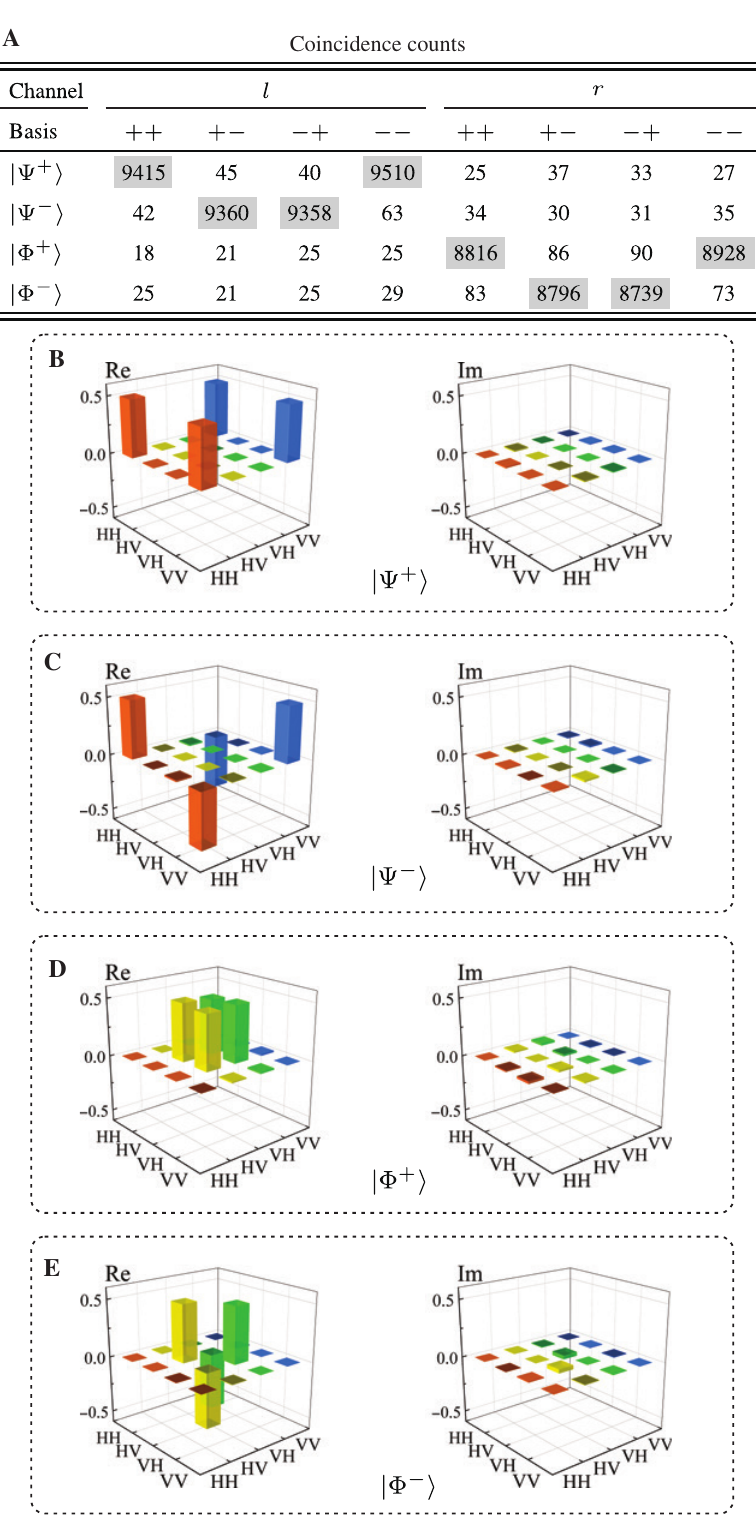
Figure 4: Bell measurement. (A) The coincidence counts in 10 s for each given channel and basis. (B–E) The corresponding density matrices reconstructed from the correct output channel. The basis states | + ⟩ and |− ⟩ stand for the eigenstates of σ